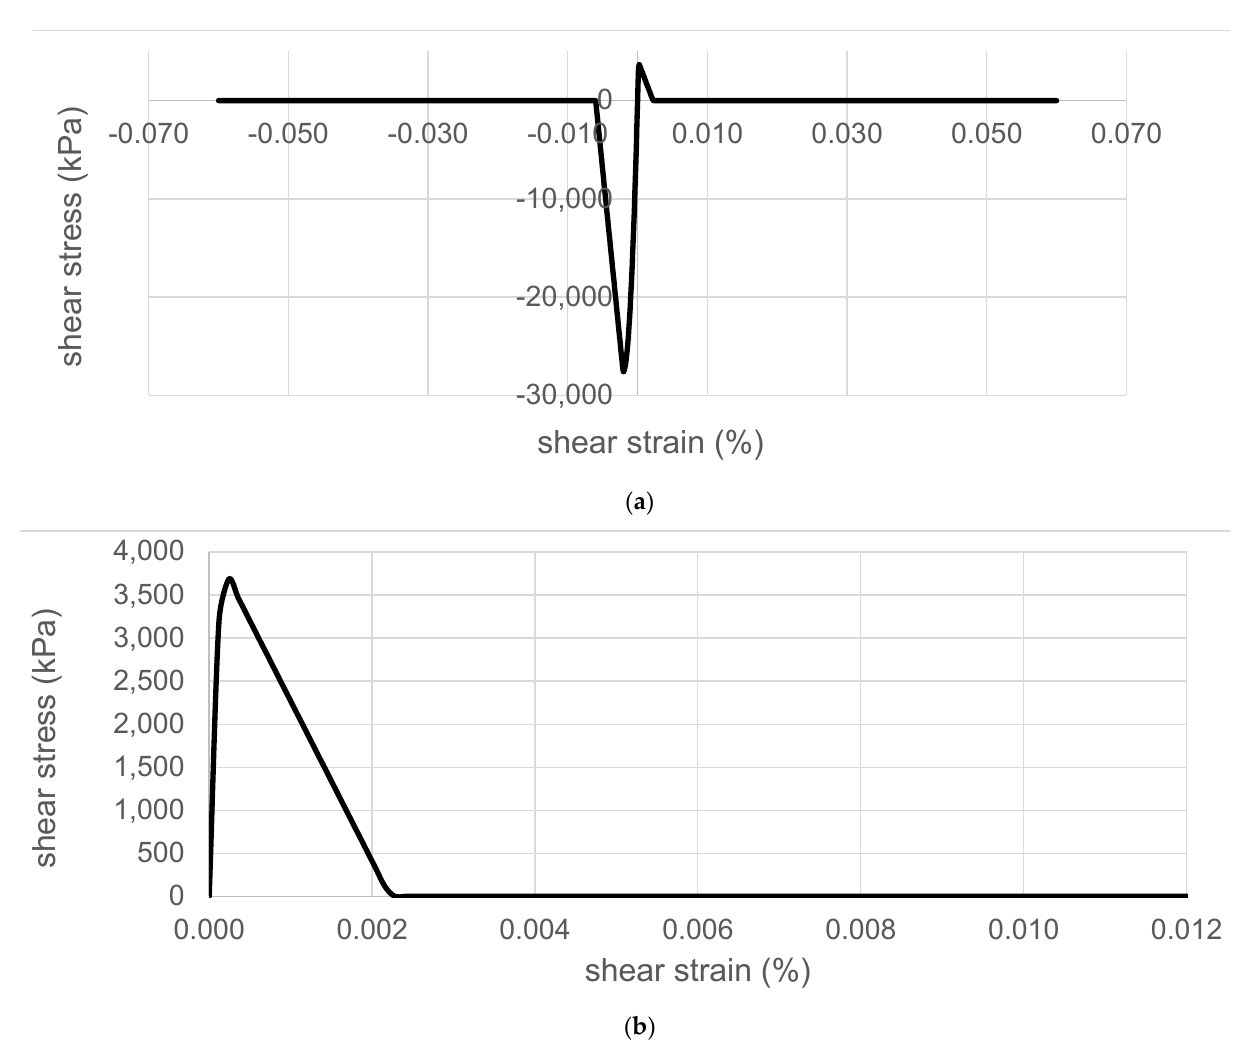
Figure 5. Shear stress vs. shear strain relationship for ( a ) Concrete02: Cover; ( b ) Concrete02: Core.